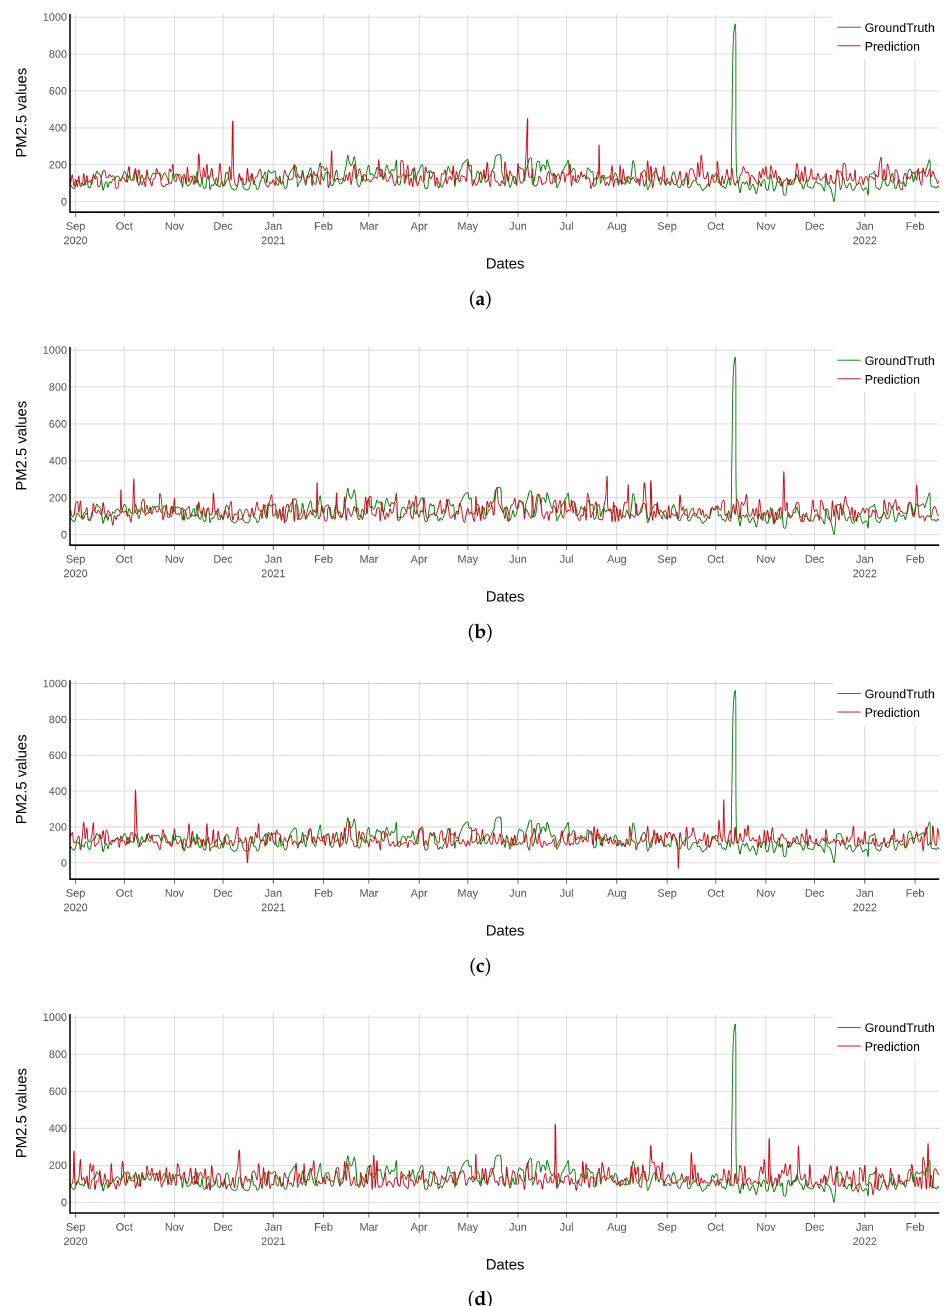
Figure 8. Shijiazhuang PM2.5 predictions. ( a ) PM2.5 predictions on the testing set using Informer; ( b ) PM2.5 predictions on the testing set using InformerStack; ( c ) PM2.5 predictions on the testing set using ResInformer; ( d ) PM2.5 predictions on the testing set using